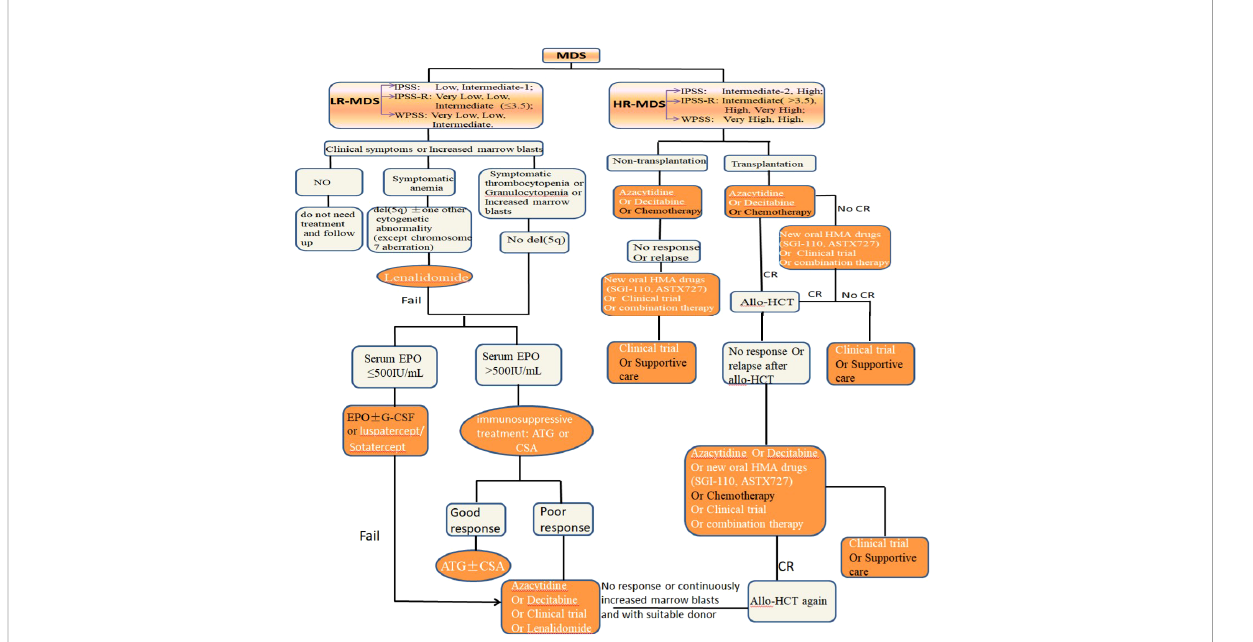
FIGURE 4 The standard treatment approach of MDS with different risk strati fi cation, and immunotherapy is an important part (orange and